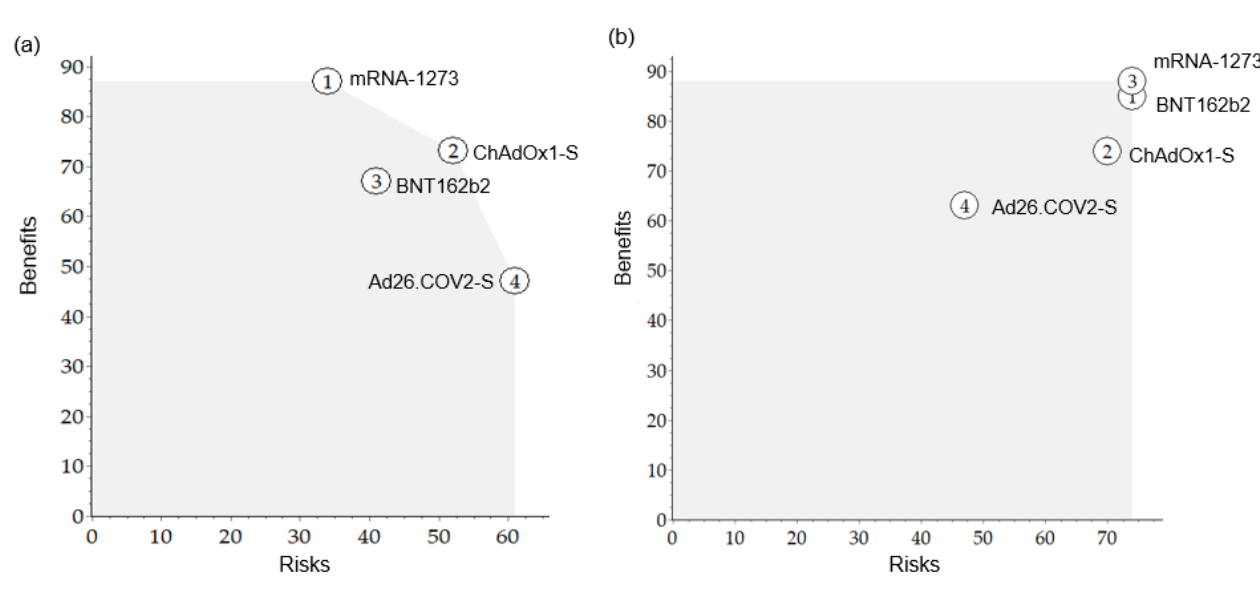
Figure 4. The map of benefits versus risks for each vaccine. ( a ) Pre-authorization, ( b ) Post-authorization.